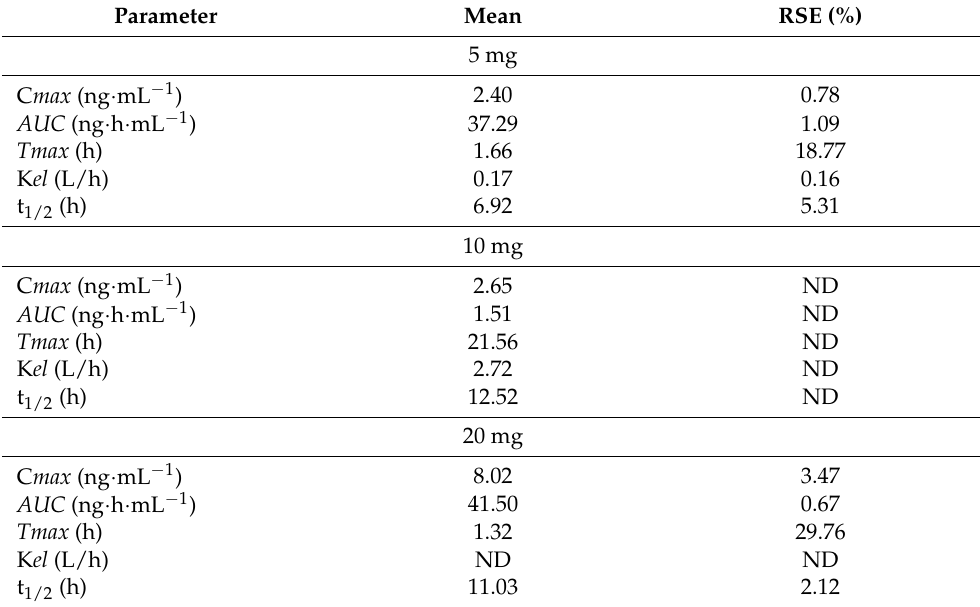
Table 4. PK parameters of the different doses of NEB.